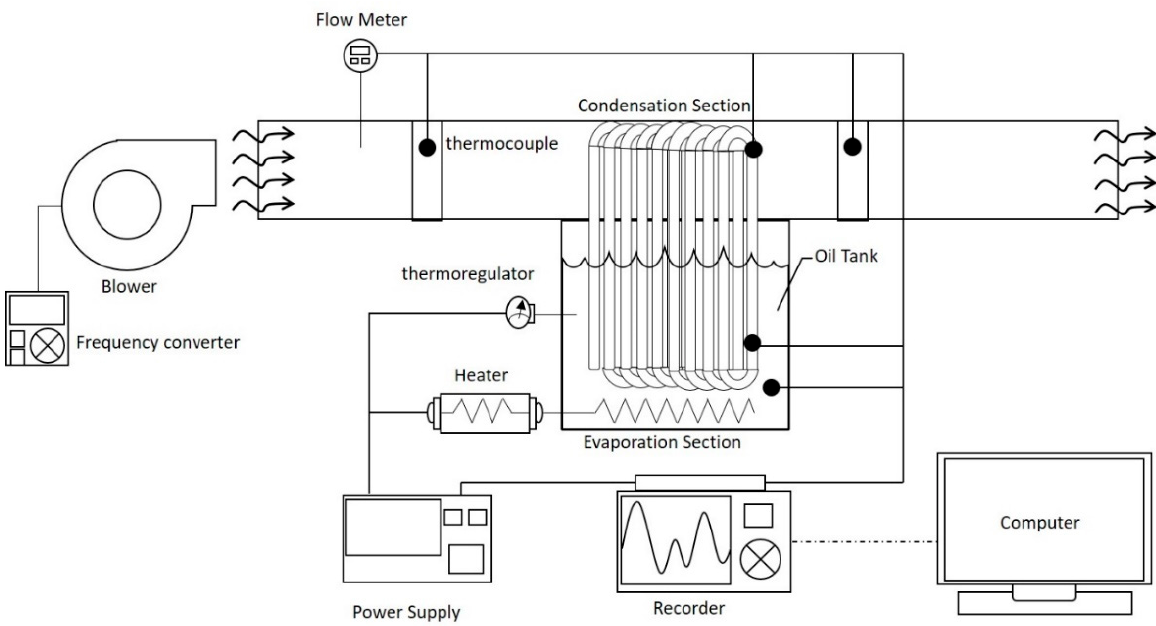
Figure 1. Schematic of the test setup. The indicated thermocouple marks only represent where temperatures were measured. A single thermocouple mark may stand for multiple thermocouples.